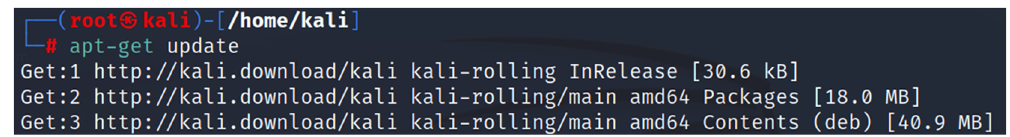
Figure 2. Updating Kali